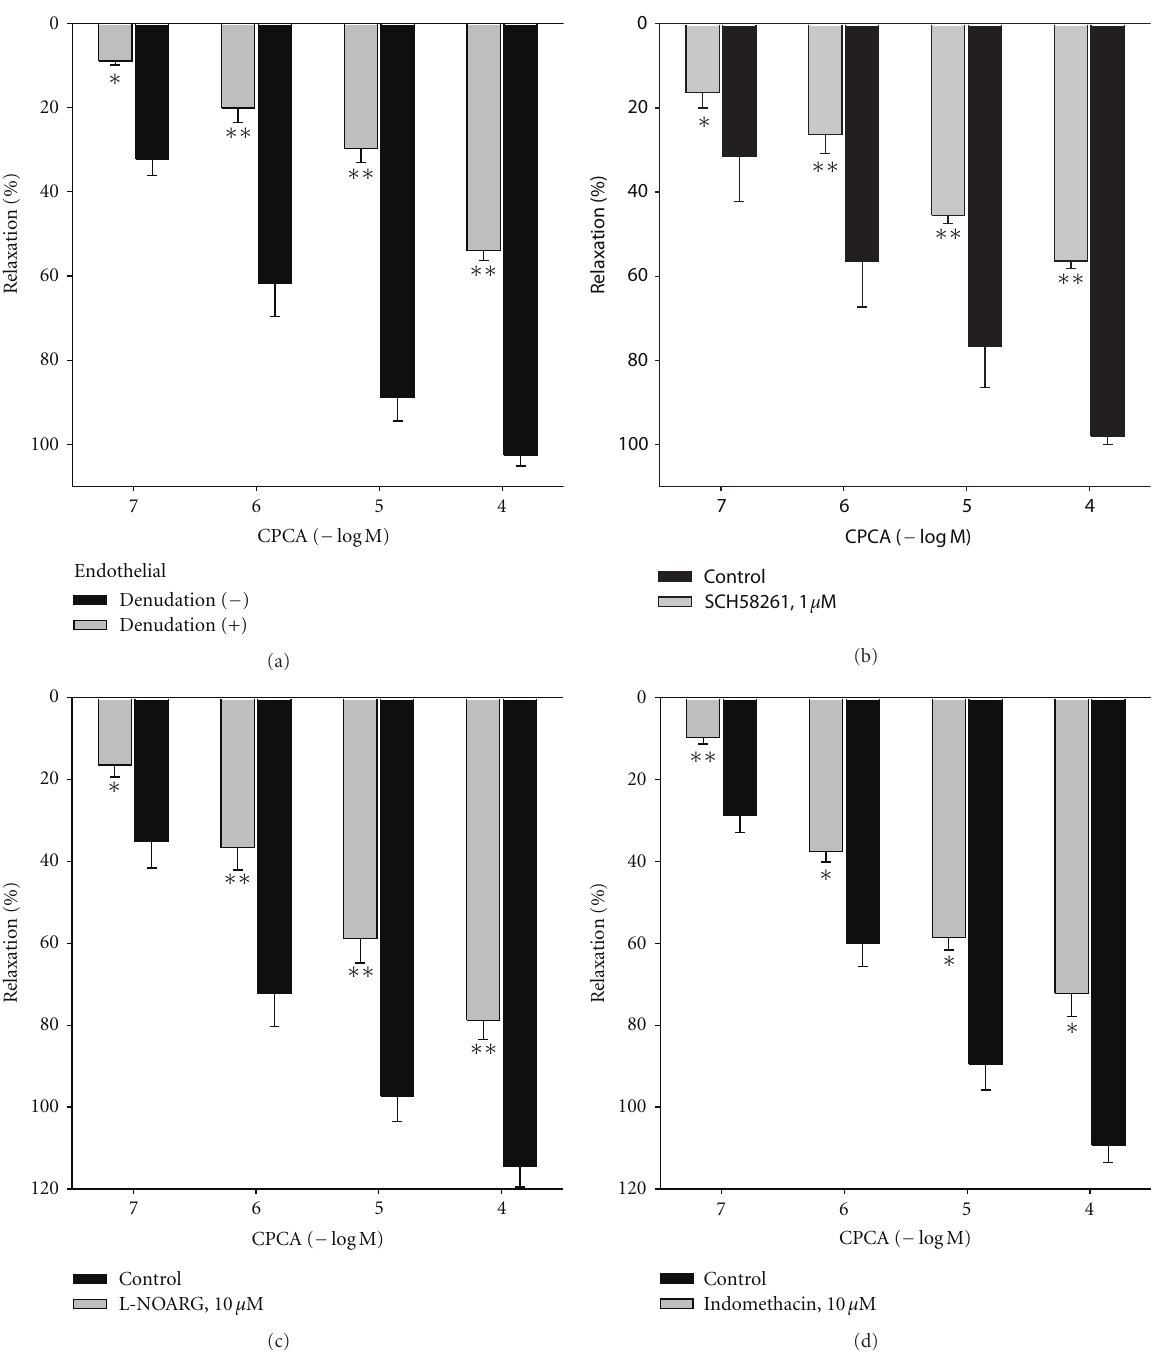
Figure 3: CPCA-induced relaxation in isolated rat femoral artery after the endothelial denudation or in the presence of SCH 58261, N G - nitro-L-arginine (L-NOARG), or indomethacin. Each point represents the mean ± SEM. ( n = 4 − 7). Vascular relaxations induced by CPCA are expressed as percentages of the precontraction induced by phenylephrine. ∗ P < 0 . 05 and ∗∗ P < 0 . 01 compared to the control relaxant e ff ect ( n = number of